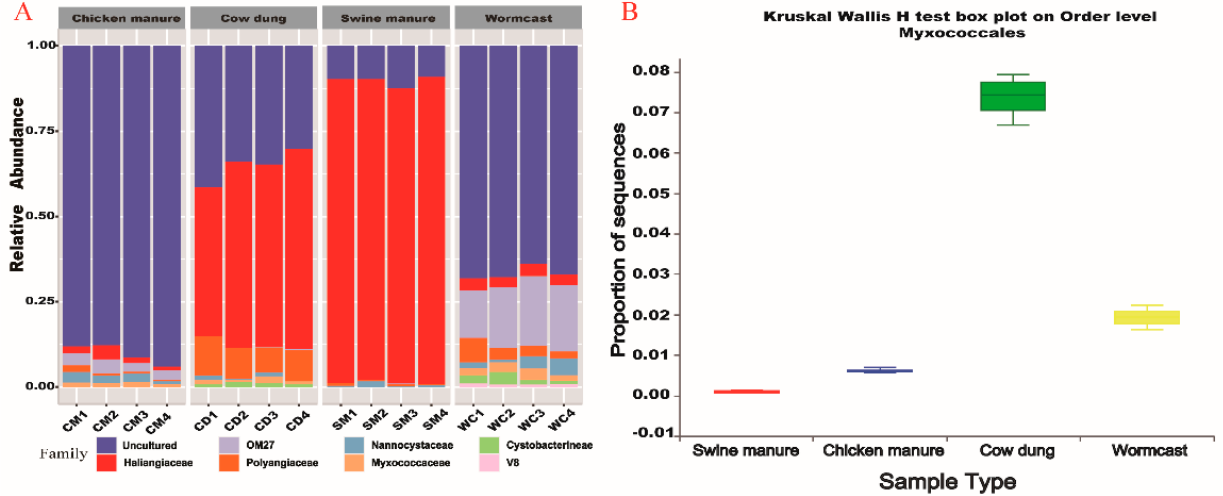
Figure 2. Myxobacteria community composition ( A ) and distribution ( B ) among the four compost manures. CM: Chicken manure, CD: Cow dung, SM: Swine manure, and WC: Wormcast.